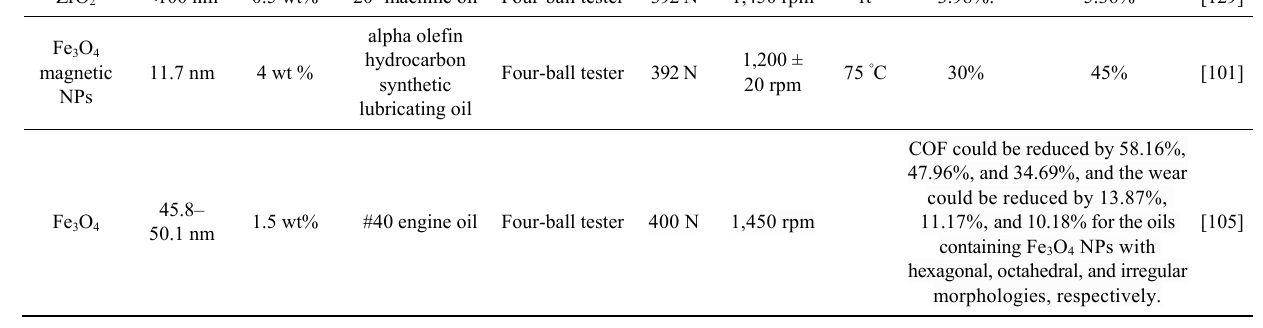
Table 3 Metal sulfide NPs as lubricant